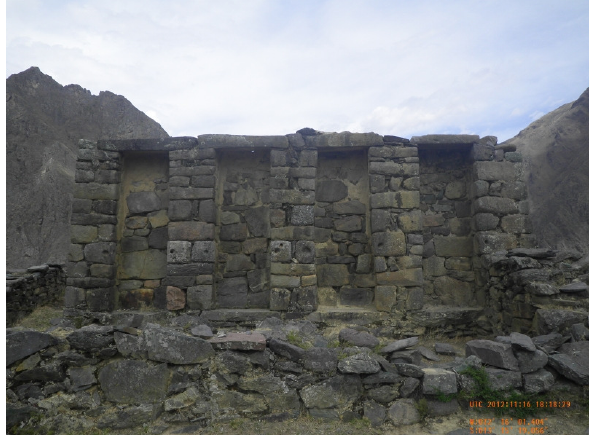
Figure 6: Ruins, 100 meter of height up the Temple of the Sun, view in east direction, © Hanzalová 2012